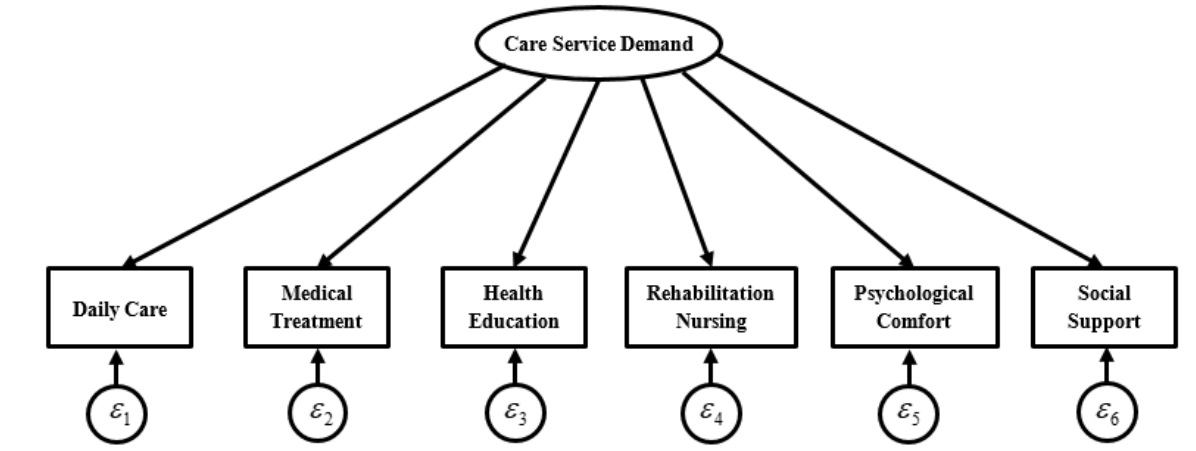
Figure 2. Confirmatory Factor Analysis Model (CFA) for Measuring Care Service Needs.